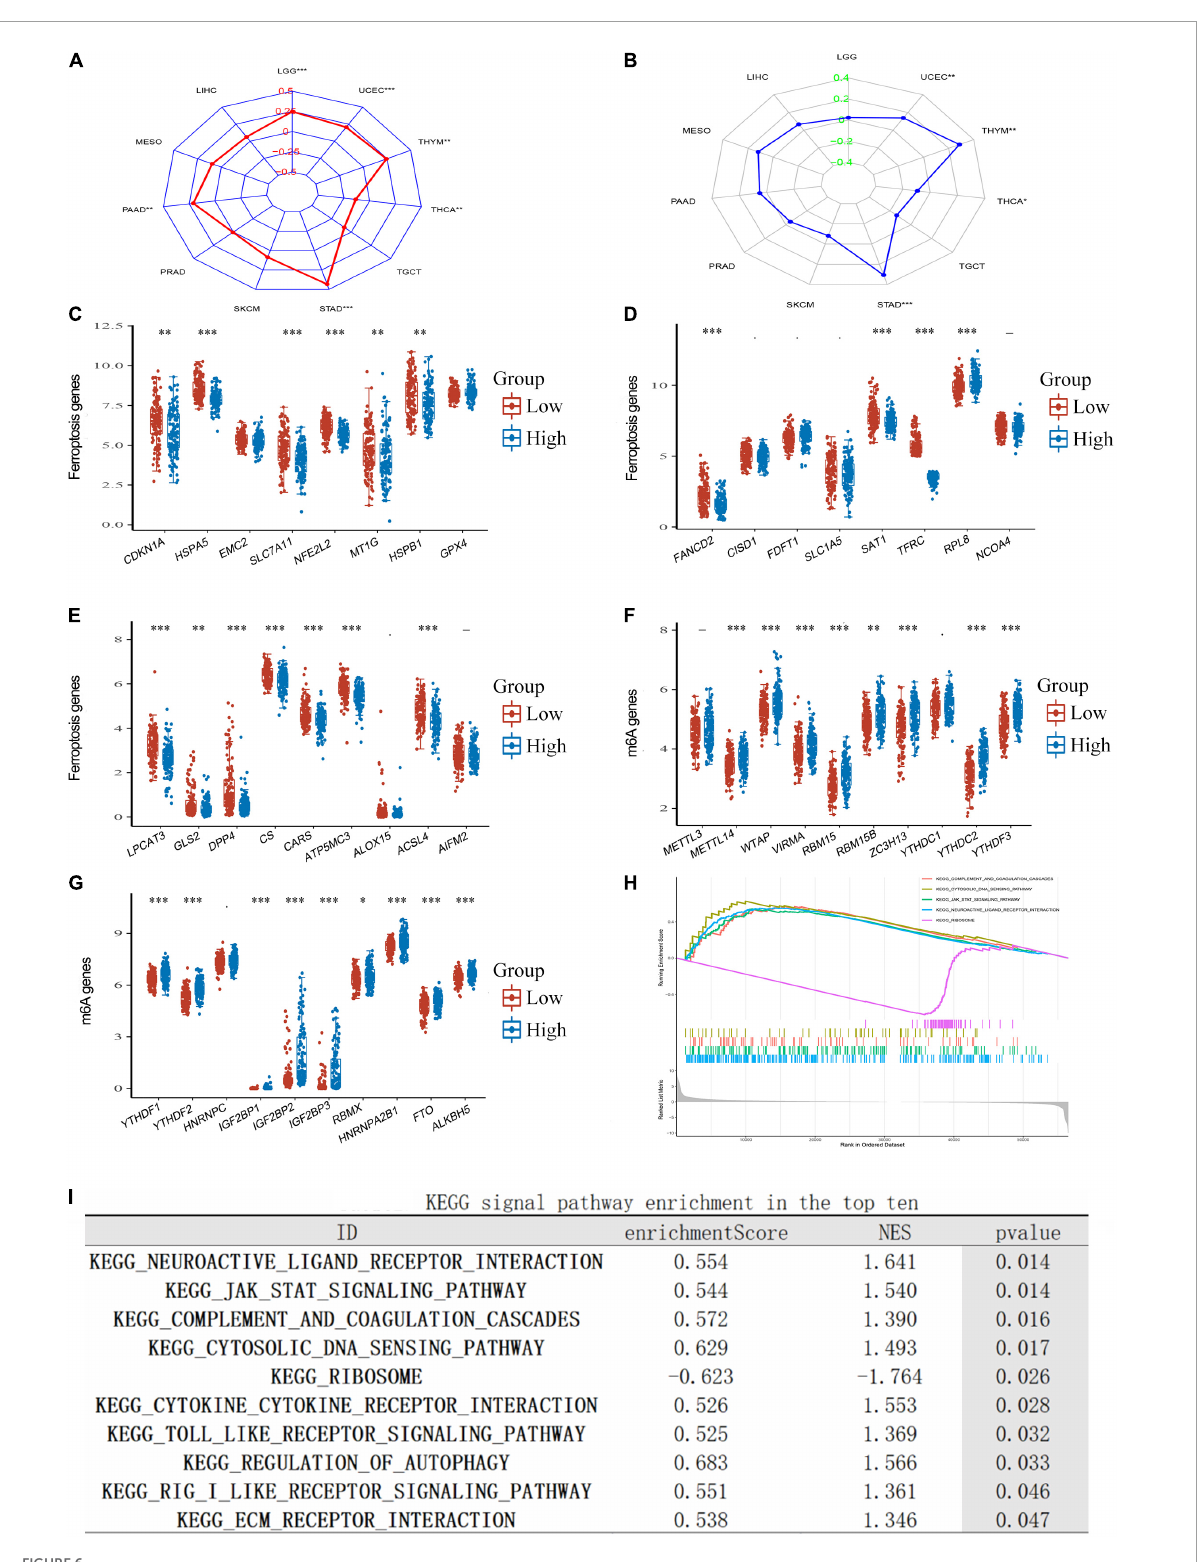
FIGURE6 The correlation of TFRC expression and TMB, MSI, m6A methylation, ferroptosis, and enrichment analysis in LGG. (A) The correlation between TFRC levels and TMB. (B) The correlation of TFRC levels and MSI. (C–E) The correlation of TFRC levels and ferroptosis. (F,G) The correlation of TFRC levels and m6A methylation. (H,I) Enrichment plots from gene set enrichment analysis (GSEA). ∗ p < 0.05, ∗∗ p < 0.01, ∗∗∗ p <